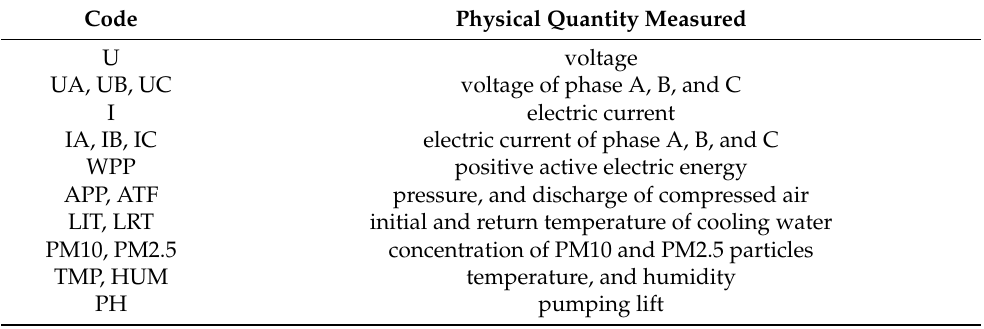
Table 3. List of primary physical quantities in the classification scheme.